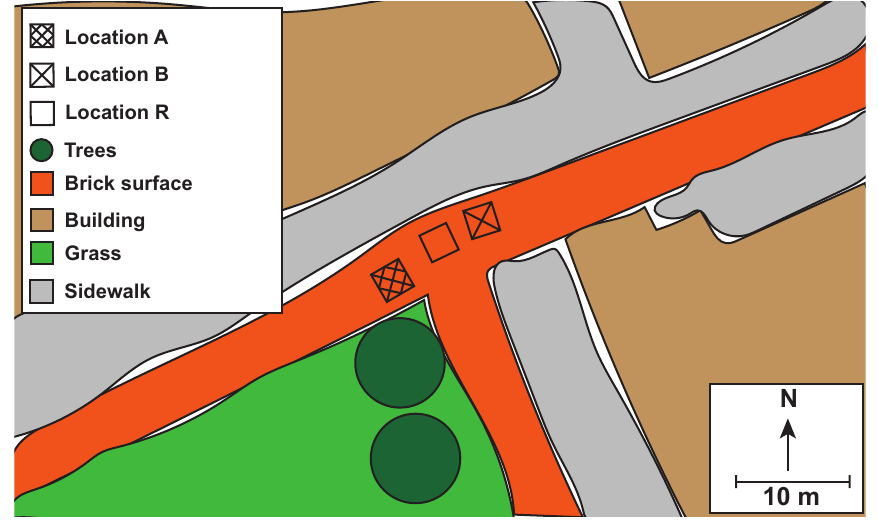
Figure 1. Sketched map of the field site in Delft, The Netherlands. Measurement locations are 3 × 3 m, and are not completely to scale on the map. The reference location (R) was a location uninfluenced by application of water and remained in the sun the whole